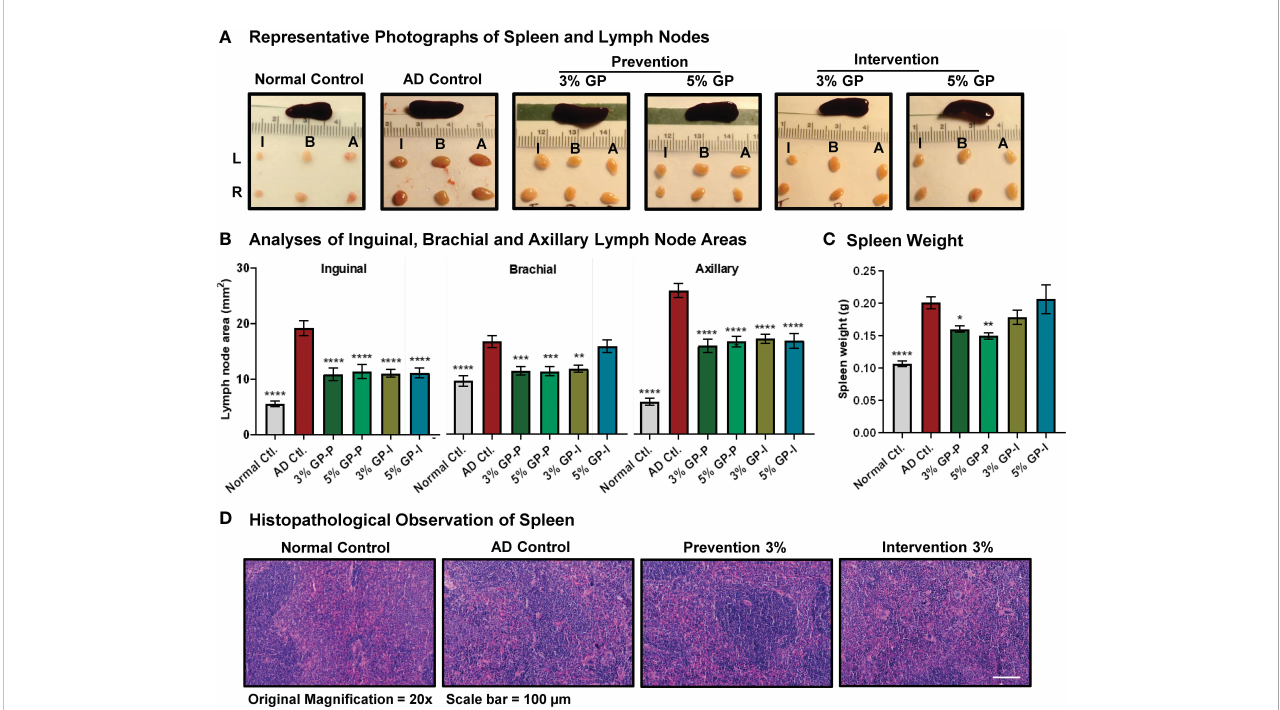
FIGURE 3 Effect of grape powder supplementation on extramedullary hematopoiesis in spleen and lymphadenopathy in atopic dermatitis. (A) After euthanasia, spleen and lymph nodes (left (L) and right (R) inguinal (I), brachial (B) and (A) axillary) were collected and imaged. (B) The cross-sectional area of all collected lymph nodes was measured using the formula (L/2*W/2* p ), and plotted. (C) The weight of spleens was measured using an analytical scale. All the analyses were compared with AD control. A one-way ANOVA with Dunnett ’ s multiple comparisons test was performed and represented as mean ± SEM with statistical signi fi cance (*p<0.05, **p<0.01, ***p<0.001, ****p<0.0001). (D) Spleen histopathological analyses were performed by our collaborating pathologist Ruth Sullivan as described in ‘ Result ’ section. Representative images at 20× magni fi cation are